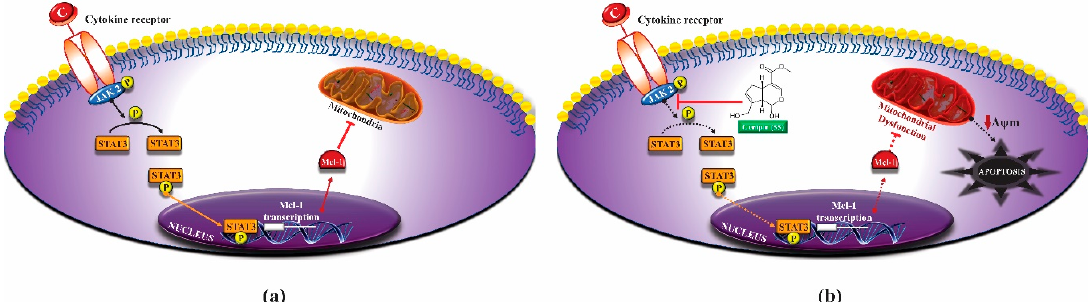
Figure 6. Apoptosis mediated by genipin through interference with myeloid cell leukemia-1 (Mcl-1) synthesis in gastric cancer cell lines: (a) Cytokine receptors without intrinsic protein kinase domain amplify extracellular signals through signal transduction via Janus Kinase (JAK) family (JAK1 to JAK3 and tyrosine kinase 2). After receptor activation, JAK2 phosphorylates the tyrosine residue of transcription factor Signal Transducer and Activator of Transcription 3 (STAT3), which enables its binding to the promoter of target genes related to survival and apoptosis. Subsequently, Mcl-1 is synthesized; (b) Genipin absorption by tumor cells induces mitochondrial dysfunction due to decreased Mcl-1 expression through the JAK2/STAT3 pathway. Δψ m, mitochondrial membrane potential; JAK2, Janus Kinase 2; Mcl-1, myeloid cell leukemia-1; STA3, Signal transducer and activator of transcription 3 [166].